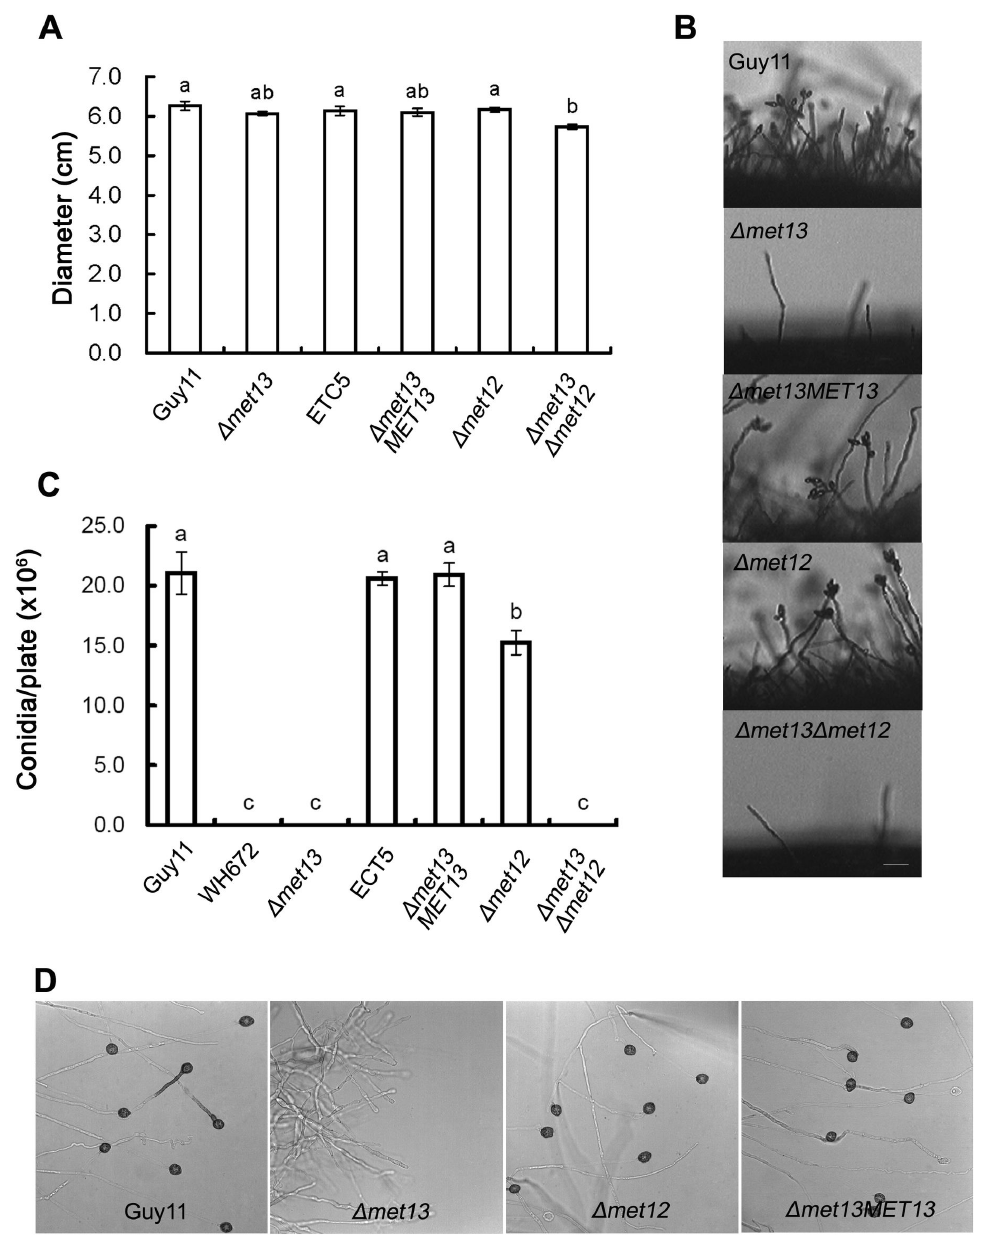
Figure 3. Phenotypic analysis of Δmet13 and Δmet12 mutants. ( A ) Bar chart showing colony diameters of the wild-type strain Guy11, Δmet13 (K56), ectopic transformant (ECT5), Δmet13MET13 (C3), Δmet12 (K12-7) and Δmet13Δmet12 (DK7) on CM medium at 25°C for 10 days. Error bars represent the standard deviation. Lower case letters indicate significant differences at P = 0.05. ( B ) Microscopic observation of conidial development. Aerial hyphae were significantly reduced and conidia were not observed in the Δmet13 and Δmet13Δmet12 mutants. The wild-type strain Guy11 and the complementation strain (Δmet13MET13) formed normal conidiophores and numerous conidia. All the tested strains grown on CM medium for 4 days were examined by light microscopy. Bar = 20 μm. ( C ) Bar chart showing the conidial production. The WH672, Δmet13 and Δmet13Δmet12 mutants were unable to produce any conidia, while the Δmet12 muatnt produced significantly less conidia than Guy11, ECT5 and Δmet13MET13 on CM medium at 25°C for 12 days. Error bars represent standard deviation. ( D ) Appressoria were formed by the hyphal tips of Guy11, Δmet13 , Δmet12 and Δmet13MET13 on hydrophobic surfaces. After 24 h incubation at 25°C in the dark, numerous appressoria were produced by Guy11, Δmet12 and Δmet13MET13 , however, no appressoria were observed after inoculation of Δmet13 . Bar = 20μm. doi: 10.1371/journal.pone.0076914.g003 PLOS ONE |